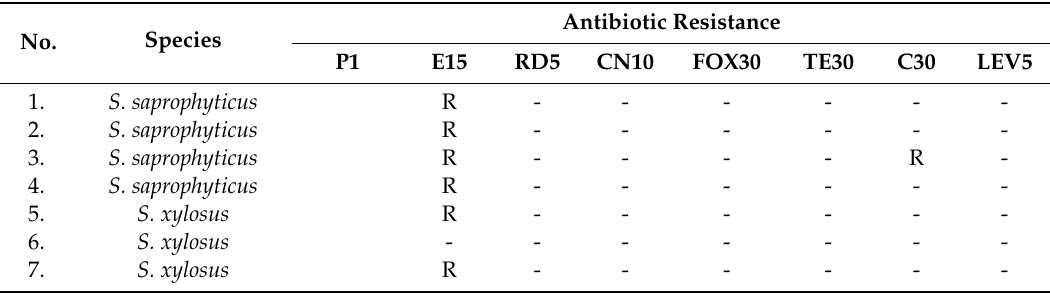
Table 7. Antibiotic resistance of staphylococci, determined by the disc di ff usion